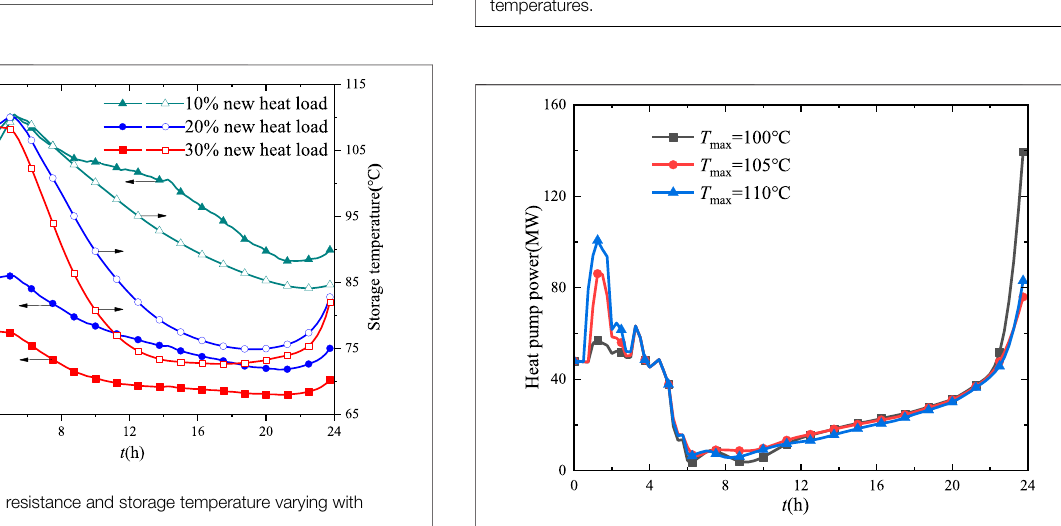
FIGURE 13 | Wind power generation under different new heat loads.